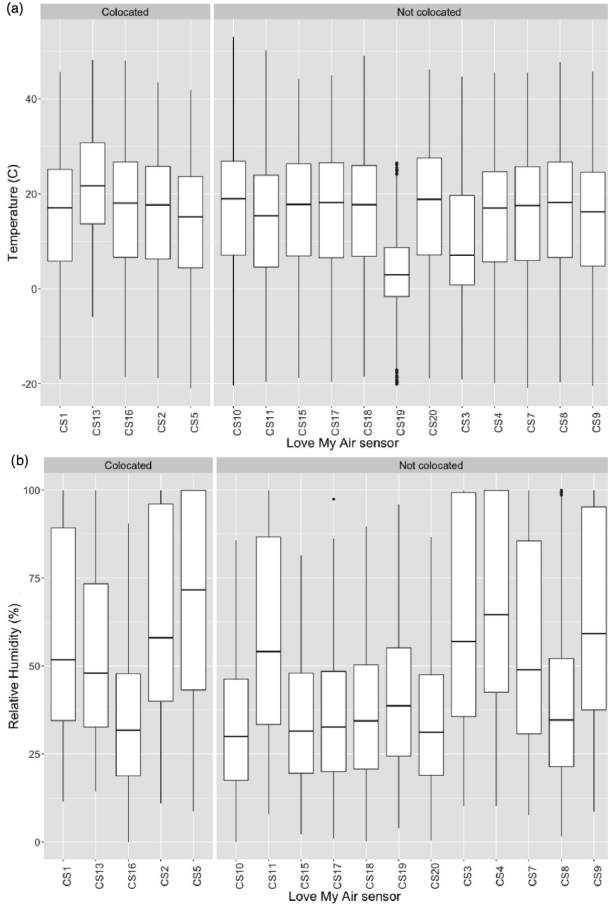
Figure 2. (a) Distribution of temperature recorded by each Love My Air sensor, (b) Distribution of RH recorded by each Love My Air sensor. The distribution of temperature and RH recorded by co- located LCS is shown on the left. The distribution of temperature and RH recorded by all LCS not used to construct the calibration models are displayed on the